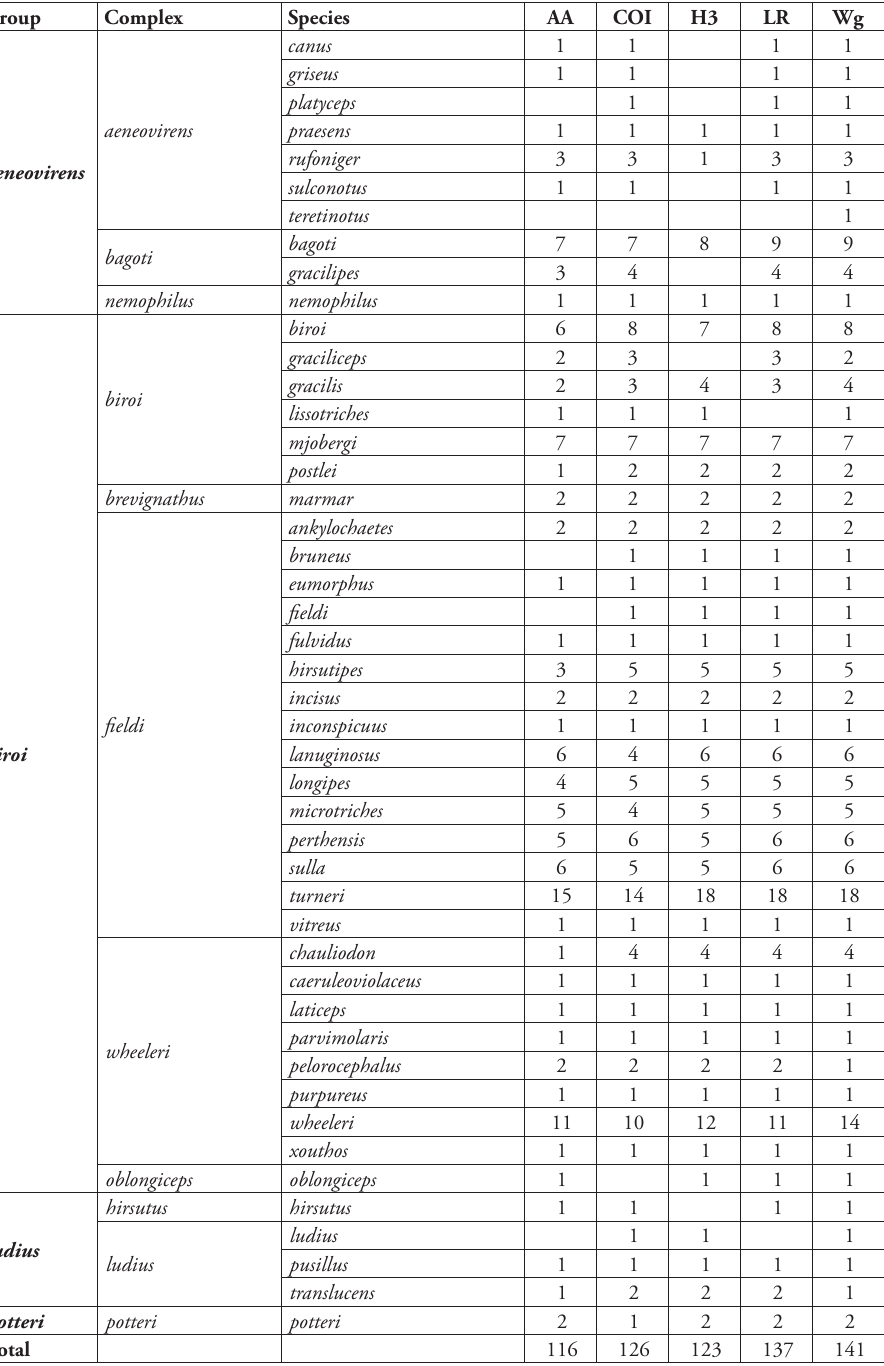
table 2. Taxonomic groups and the number of gene sequences generated. Group Complex Species AA